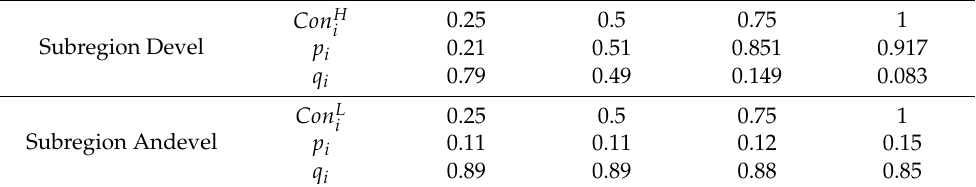
Table 3. Estimates of probabilities of budget surpluses and deficits in sub-regions with different values con i ∈ CON of deductions from personal income tax. Con H Subregion Devel